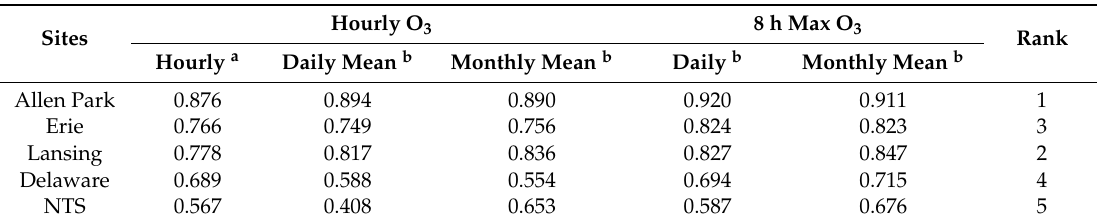
Table 5. Correlation coe ffi cients between smog season O 3 concentrations at Windsor and each of the five US sites. All correlations are significant at p < 0.05.